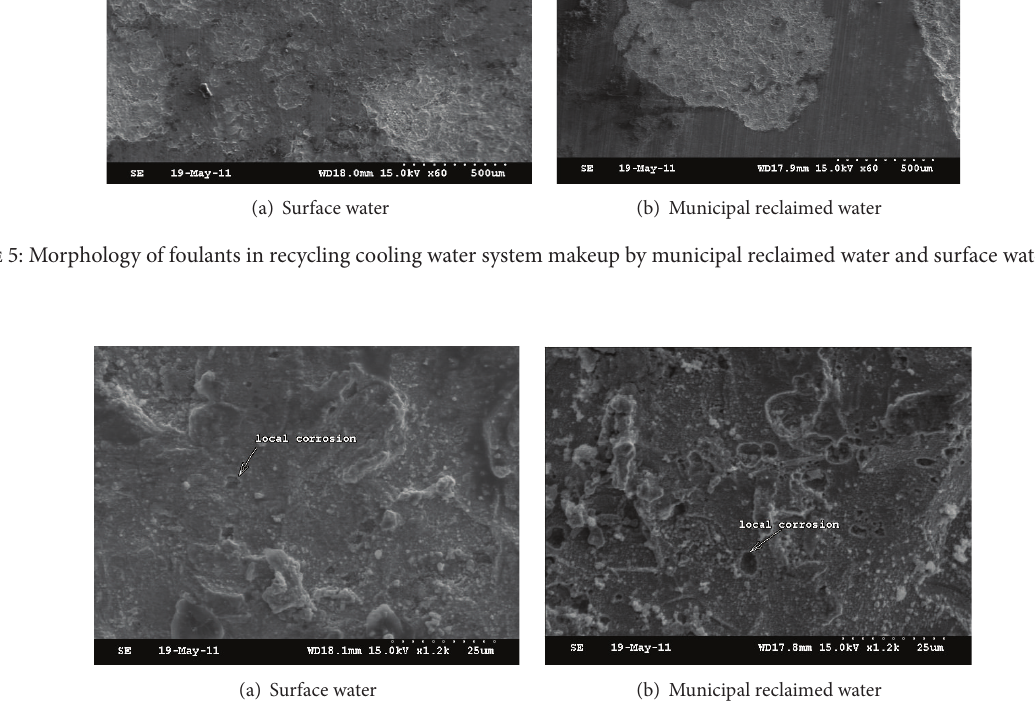
Figure 6: Corrosion morphology comparison in recycling cooling water system makeup by municipal reclaimed water and surface water.